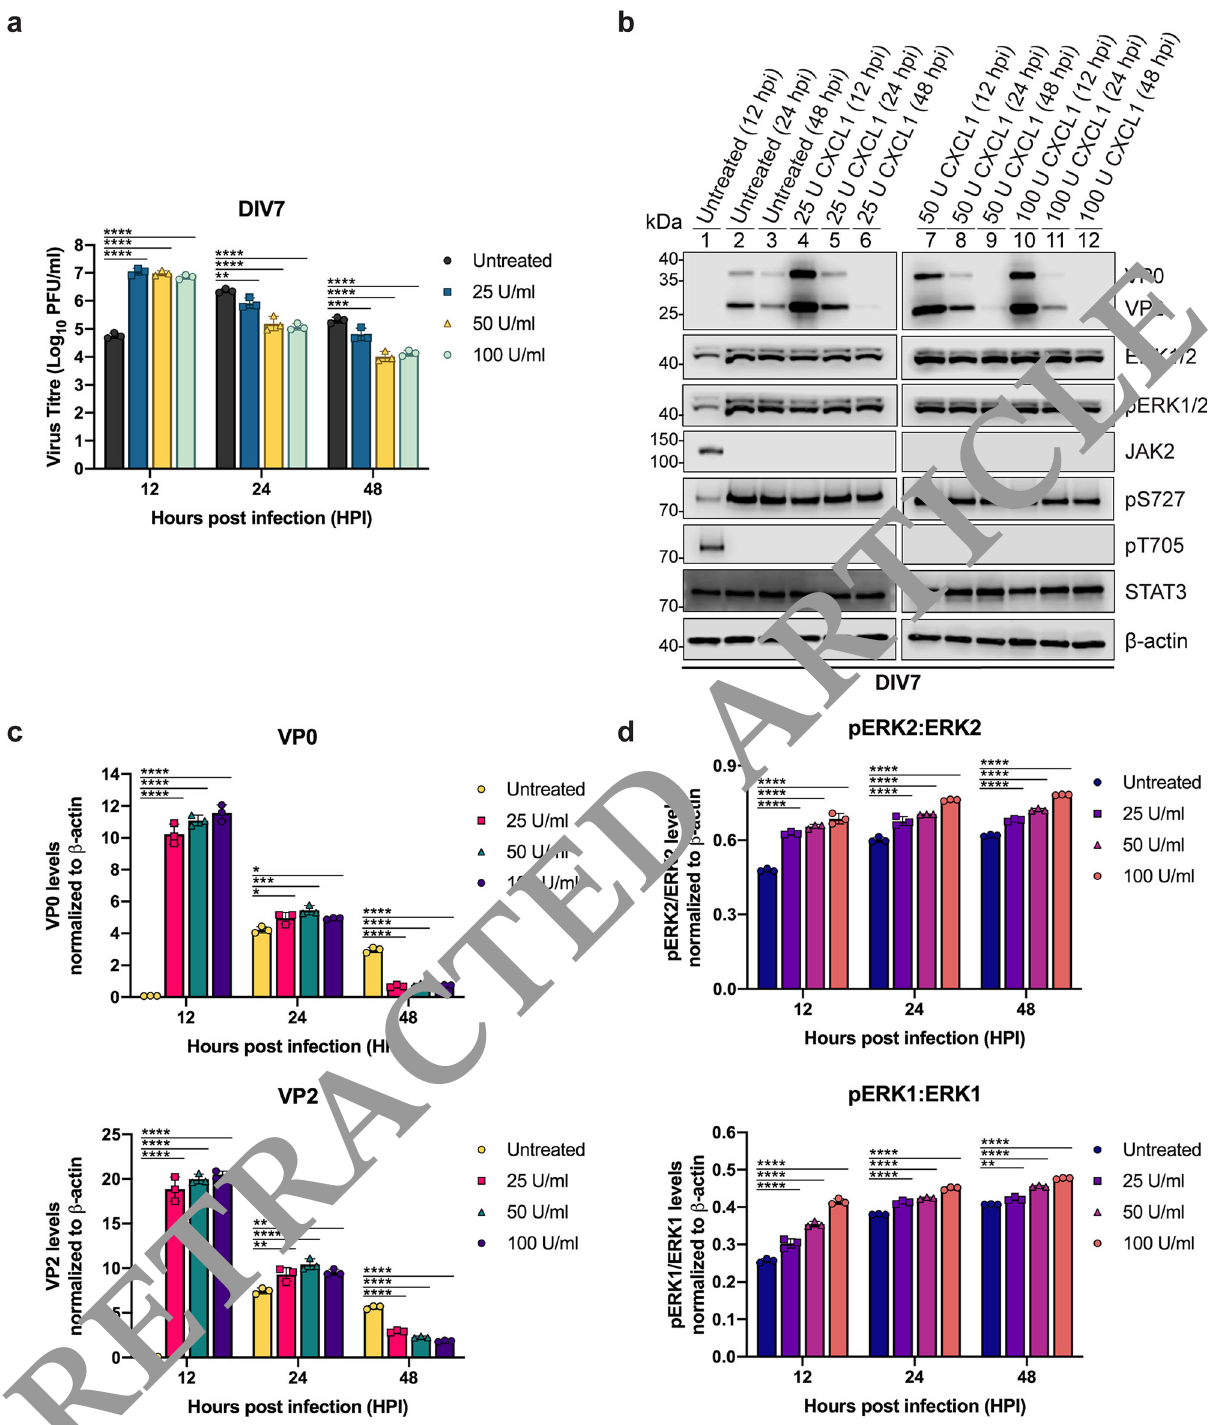
Fig. 4 CXCL1 signaling activates downstream ERK1/2 via CXCR2 to enhance viral replication in neuronal cultures. a HEVA71 viral titers increase in CXCL1-pretreated DIV7 neuronal cultures. Exact P values for: 25 U/ml at 24 hpi = 0.0033 and 48 hpi = 0.0009. b Immunoblotting of cell lysates from CXCL1-pretreated or untreated S41-infected DIV7 neuronal cultures against VP0, VP2, ERK1/2, pERK1/2, JAK2, pS727 (STAT3), pT705 (STAT3) and STAT3. CXCL1 pre-treatment accelerates the appearance HEVA71 viral proteins. Elevated pERK1/2 and ERK1/2 levels also emerged earlier. Immunoblot representative of 3 biological repeats is shown. Bar charts below show the quanti fi cations for each protein. c High levels of VP0 and VP2 were detectable at 12 hpi only with exposure to CXCL1. Exact P values for VP0: 25 U/ml at 24 hpi = 0.0195, 50 U/ml at 24 hpi = 0.0001 and 100 U/ml at 24 hpi = 0.002. Exact P values for VP2: 25 U/ml at 24 hpi = 0.001 and 100 U/ml at 24 hpi = 0.0215. d pERK1/2 to ERK1/2 ratios were higher in pretreated cultures versus controls in a CXCL1 dose-dependent manner at all timepoints. Exact P value for pERK1 to ERK1 ratio: 25 U/ml at 48 hpi = 0.0094. β -actin was used as a loading control for immunoblotting experiments. MOI of 1 was used for all experiments. Data are expressed as the average with error bars representing ±SD from 3 independent experiments ( n = 3). Statistical analyses were performed with two-way ANOVA corrected using Bonferroni post-test. (* P < 0.05, ** P < 0.01, *** P < 0.001 and **** P < 0.0001). Source data are provided as a Source Data fi